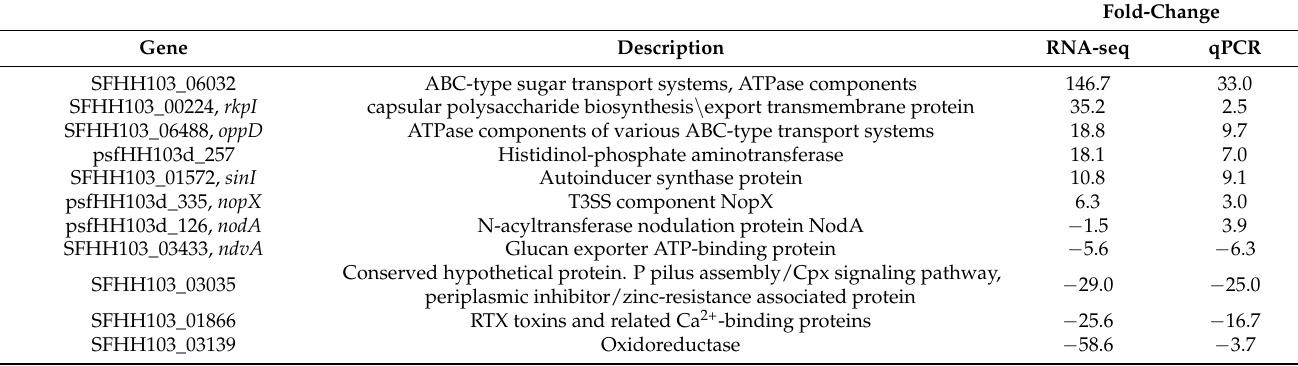
Table 3. RNA-seq data validation using q RT-PCR. The expression of 11 S. fredii genes was measured both in the presence or absence of 400 mM mannitol. For q RT-PCR, fold-change values were calculated using the ∆∆ Ct method and normalised to the reference 16S rRNA